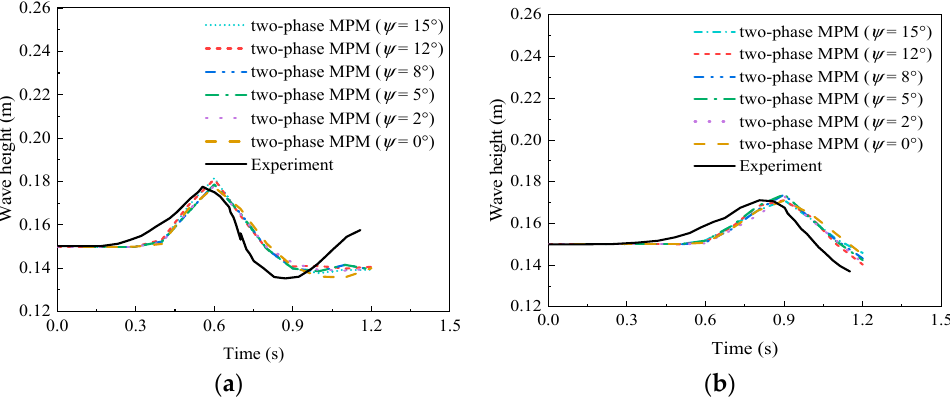
Figure 14. In fl uence of dilatancy angle of sliding sand: time history curve of the free water surface at two di ff erent locations: ( a ) X1 = − 0.3 m; ( b ) X2 = − 0.6 m.